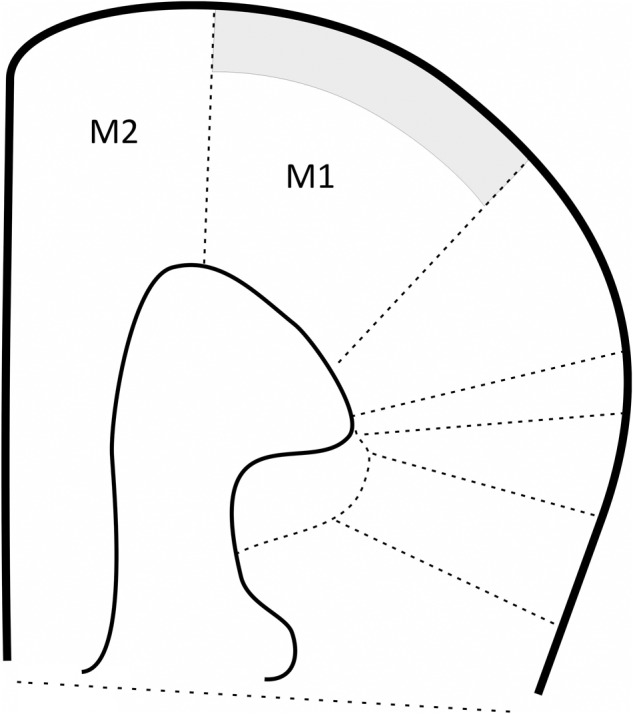
Schematic illustration showing mice cortex coronal slice (Paxinos and Franklin, 2012). Area colored in gray represents recording zone.